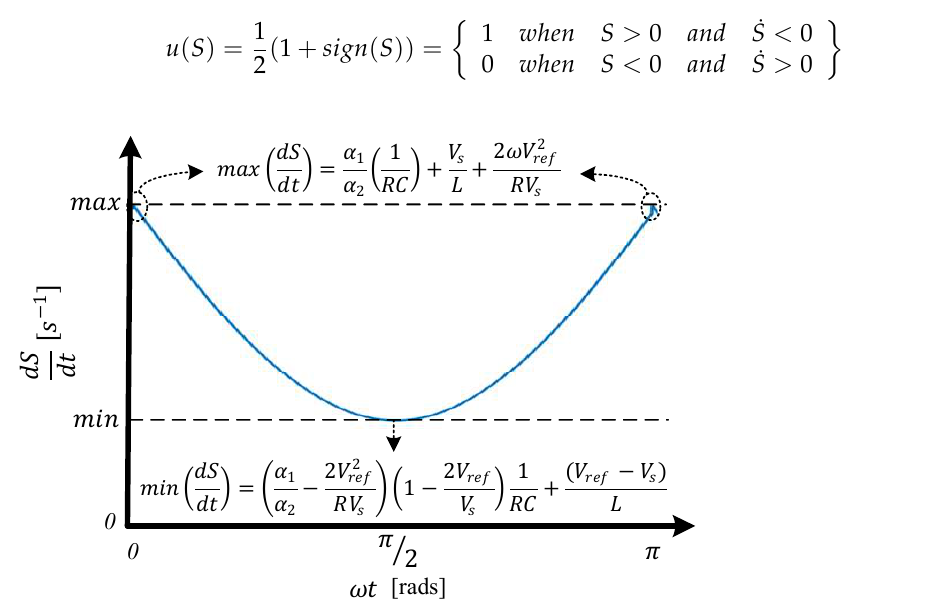
Figure 4. dS / dt for existence condition when u =